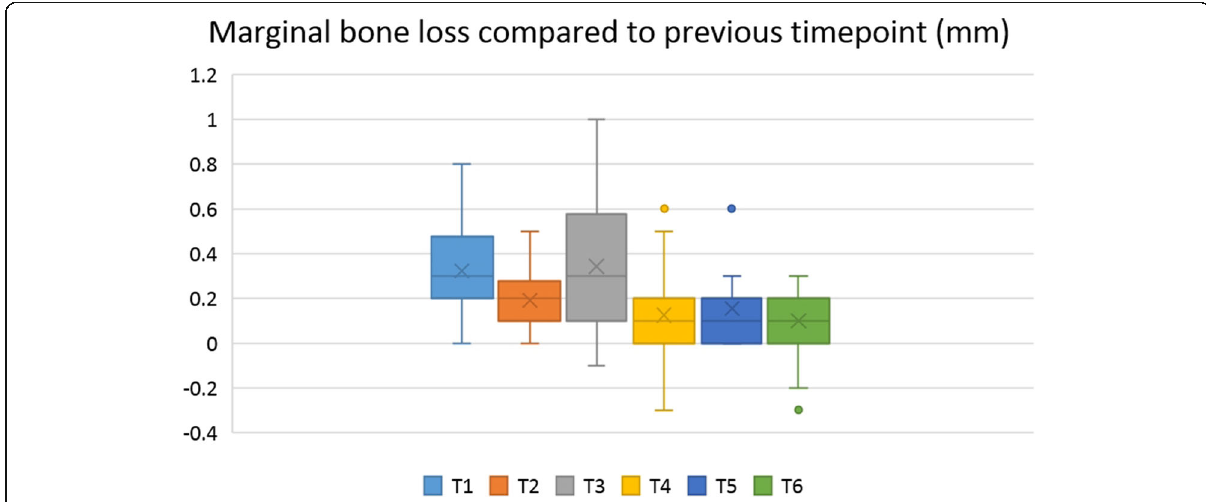
Fig. 7 Marginal bone loss at each time point compared to MBL at the previous visit. 3months after installation, T2: at prosthetic loading, T3: 1year after installation, T4: 2years after installation, T5: 3years after installation, T6: 5years after installation. Mean MBL change compared to previous time point significantly differed between T2 and T1, T3 and T2, and T4 and T3. MBL change at T4, T5, and T6 did not differ significantly ( p